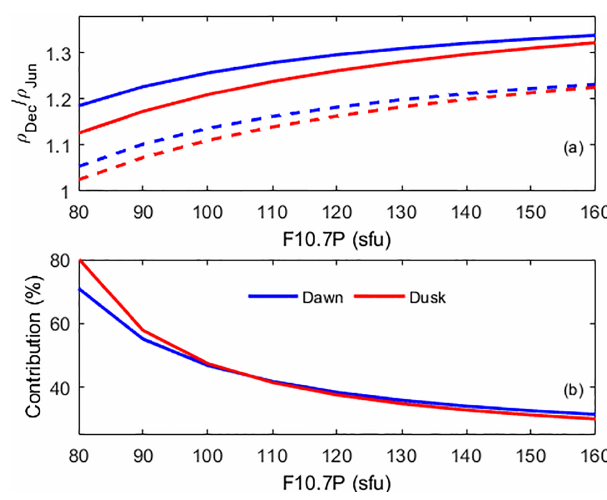
Figure 7. (a) The latitudinal mean R from GOCE observations for solar flux at the Sun–Earth distance (dashed line) and 1AU (solid line), and (b) the estimated contribution of the Sun–Earth distance under different solar activity conditions at the dawn and dusk LST